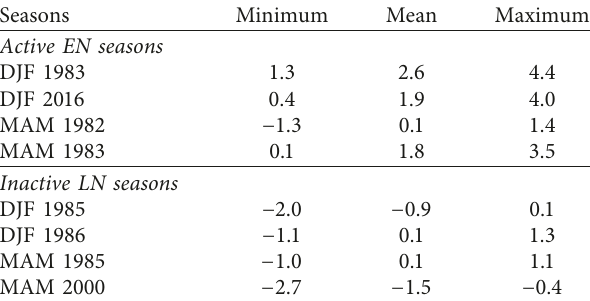
Table 1: Minimum, mean, and maximum values of global at- mospheric angular momentum (AAM; kg during the active EN and inactive LN